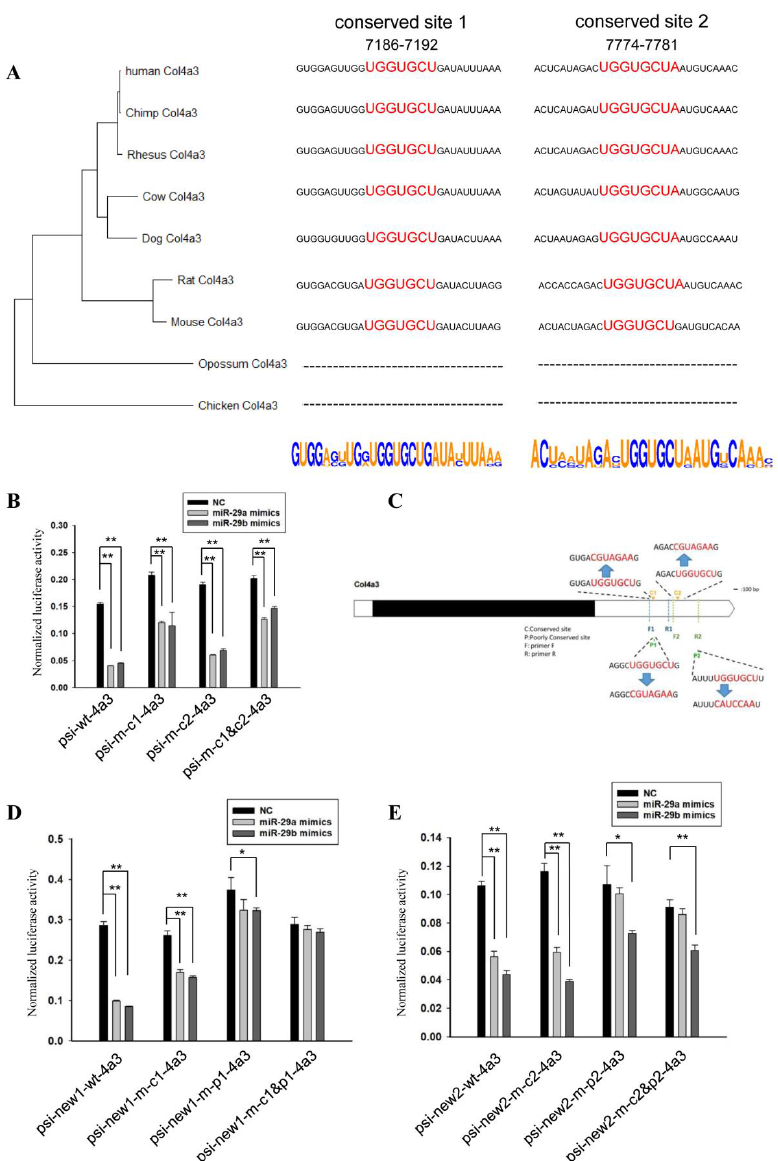
Figure 3. MiR-29 directly regulates the 3 (cid:48) UTR of Col4a3 . ( A ) Phylogenetic tree constructed from the 3 (cid:48) UTRs of Col4a3 in multiple species. Analysis of miR-29 binding sites and flanking sequences in the 3 (cid:48) UTRs of Col4a3 in multiple species. ( B ) The effect of miR-29a or miR-29b mimics on the relative luciferase activity of the psi-wt-4a3 vector (psiCHECK TM -2 containing wild-type 3 (cid:48) UTR of Col4a3 ), psi-m-c1-4a3 vector (psiCHECK TM -2 contained 3 (cid:48) UTR of Col4a3 mutated at conserved site